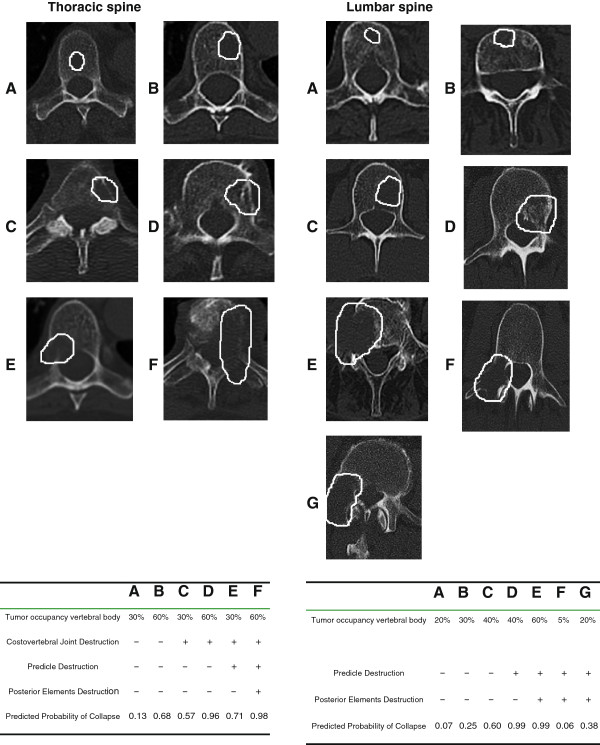
Taneichi score [20].